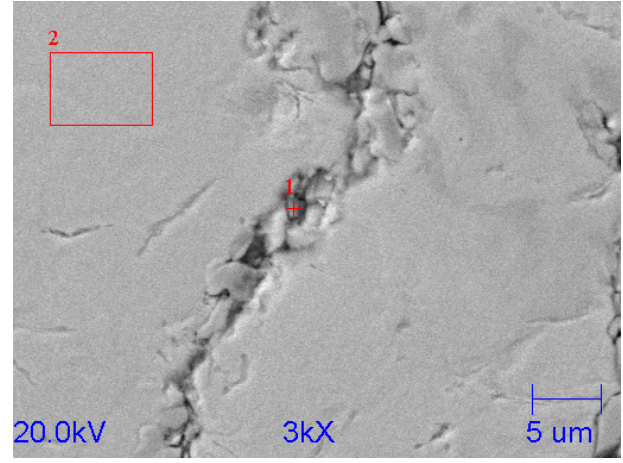
Figure 11. SEM microstructure of reference chromium cast iron.